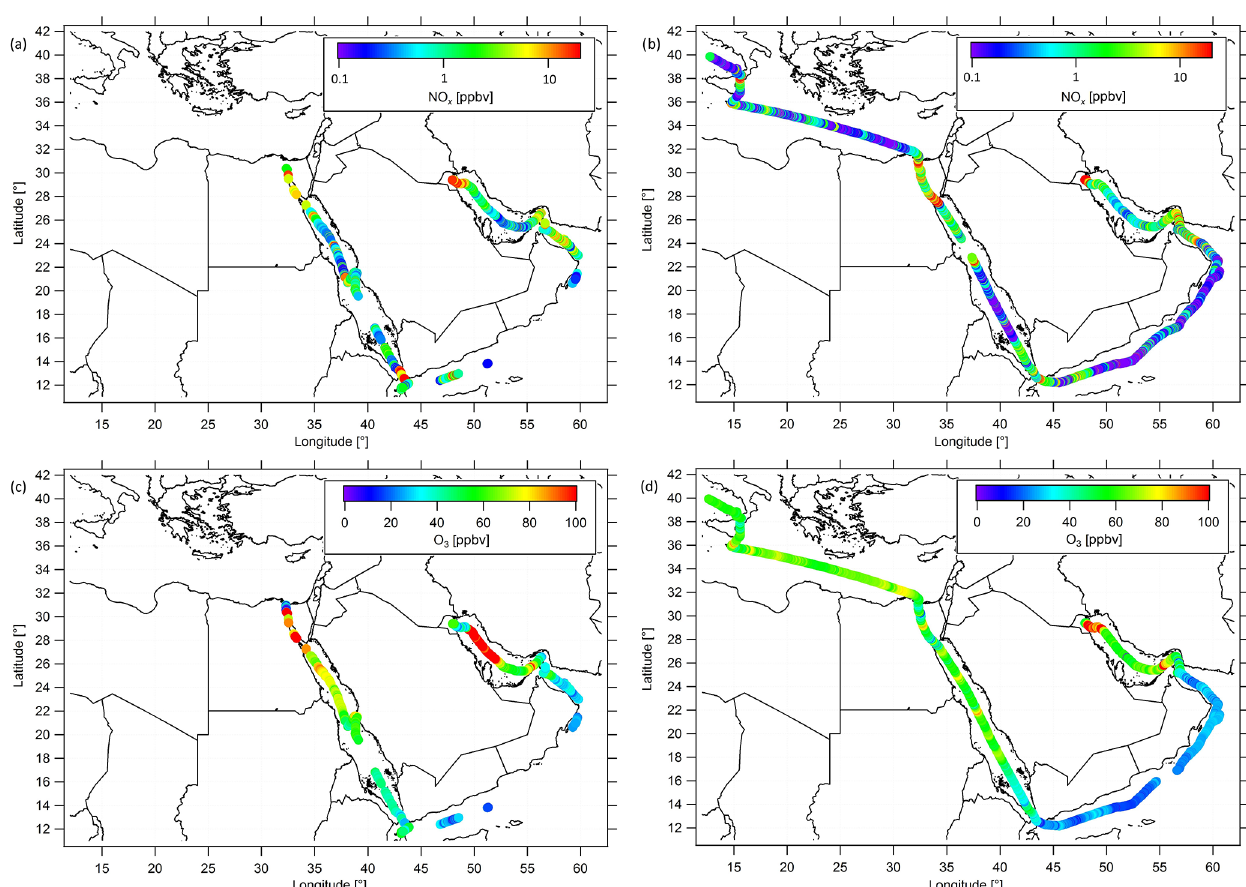
Figure 3. Ship cruises with color-scaled NO x mixing ratios (logarithmic scale) during (a) the first and (b) the second leg, and color-scaled O 3 mixing ratios (linear scale) during (c) the first and (d) the second leg. Note that both NO x and O 3 have been filtered for contamination from the ship’s